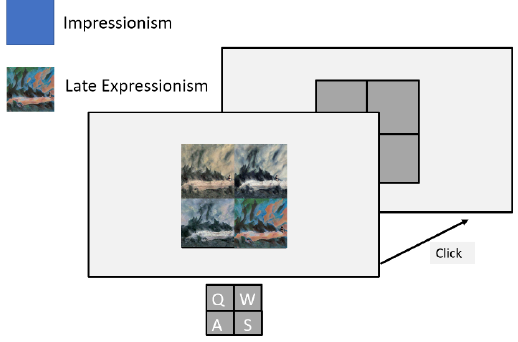
Figure 4. Singleton search experiment setup: The subject sees four images arranged in a grid. One stimulus is presented in one style and is the target, the others are presented in a different style and are the distractor